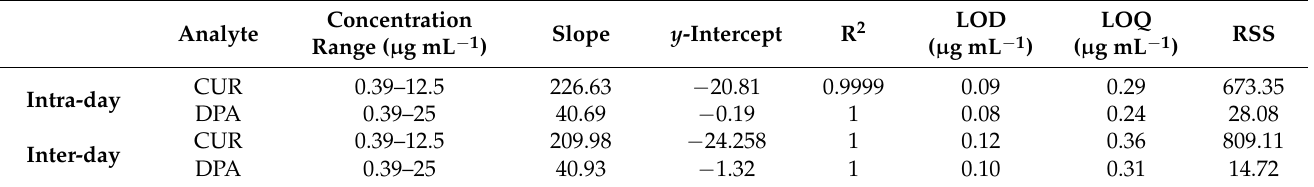
Table 2. Properties of the calibration curve for quantification of CUR and DPA with LOD and LOQ values ( n = 6).